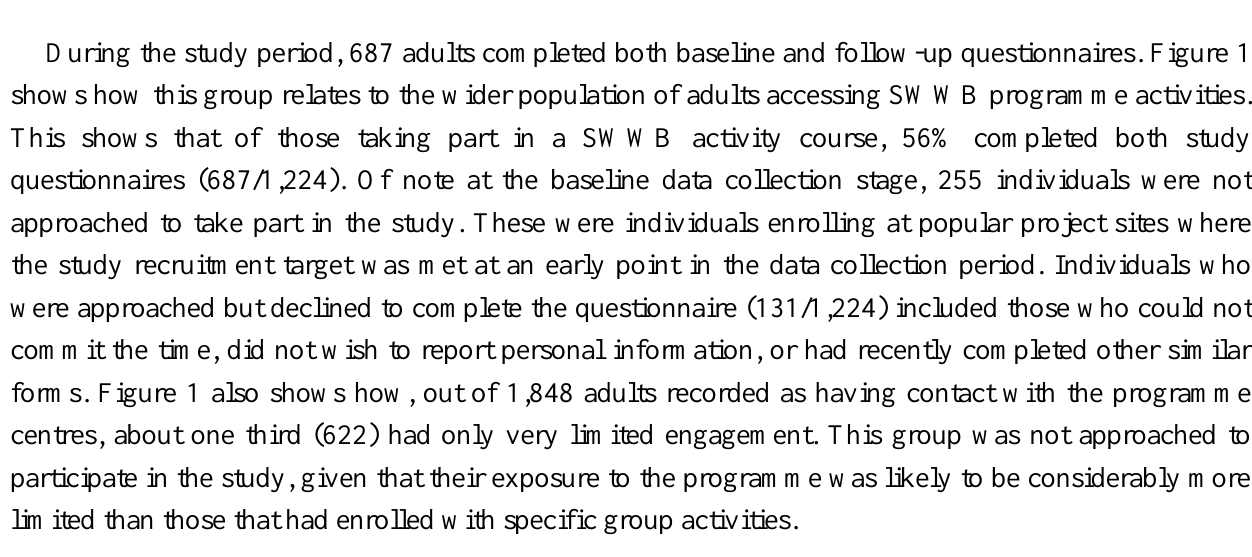
Figure 1. Flow diagram for study